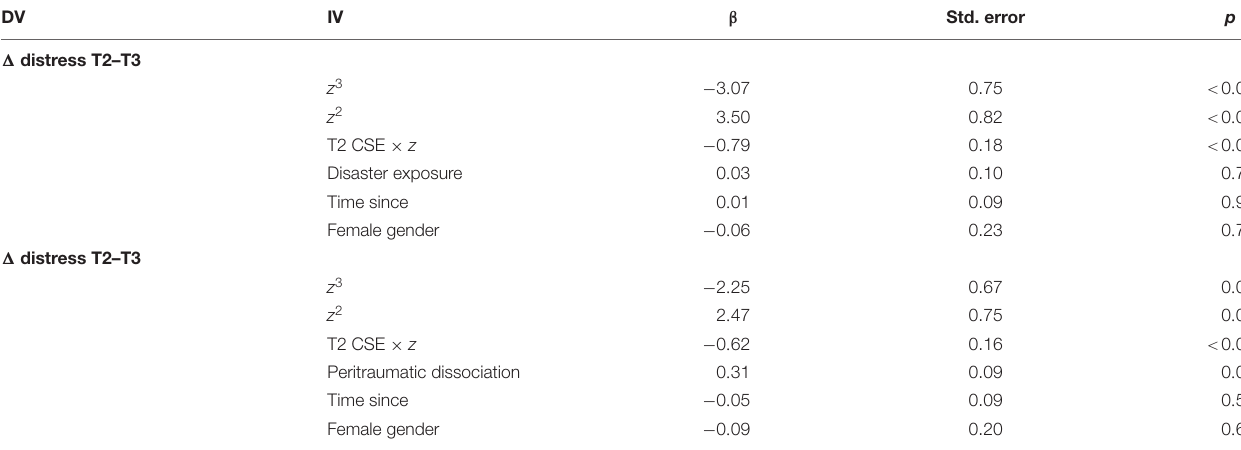
TABLE 5 | Standardized coefficients, standard error, and p -values for the cusp model in distress between time 2 and time 3 for Study 2. DV IV β Std. error